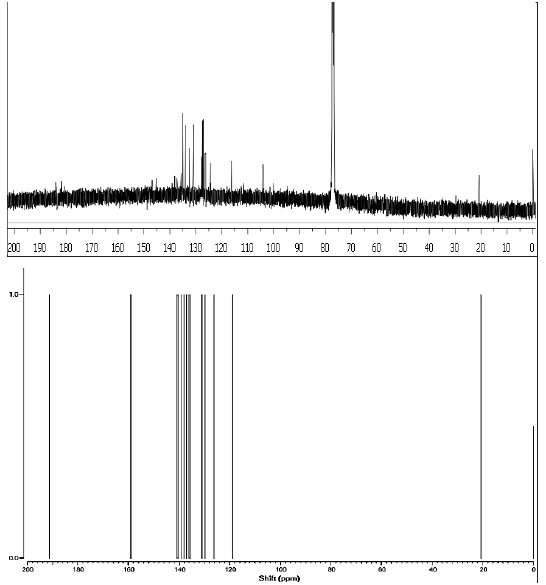
Figure 4: Experimental (above) and theoretical (below) 13 C-NMR spectra of the PINQ.